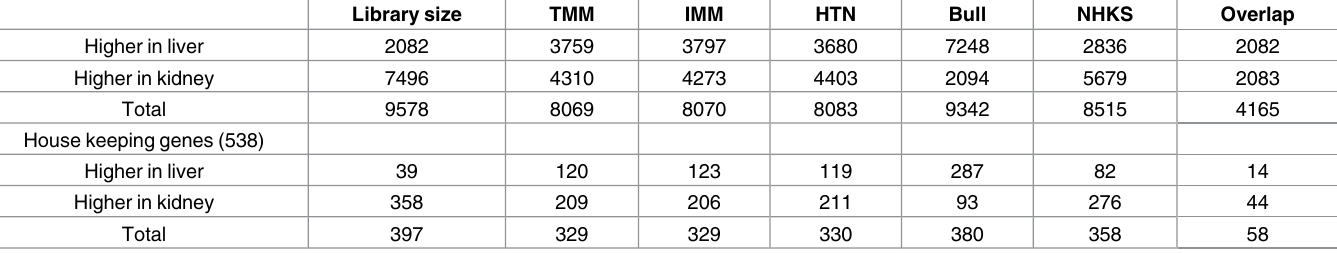
Table 1. The number of DE genes between liver and kidney at a cutoff p-value < 10 − 4 for different normalization